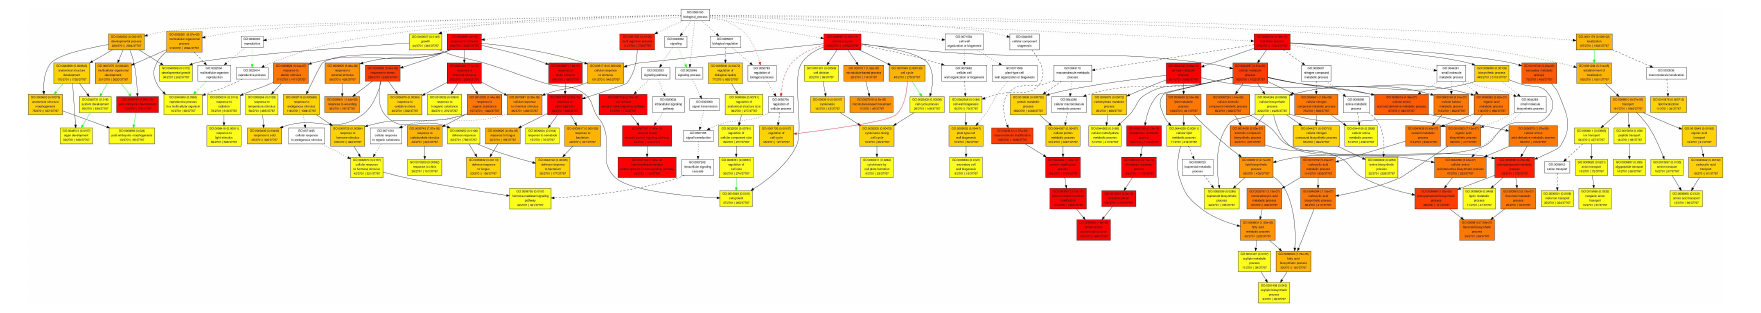
Figure A1. Biological process